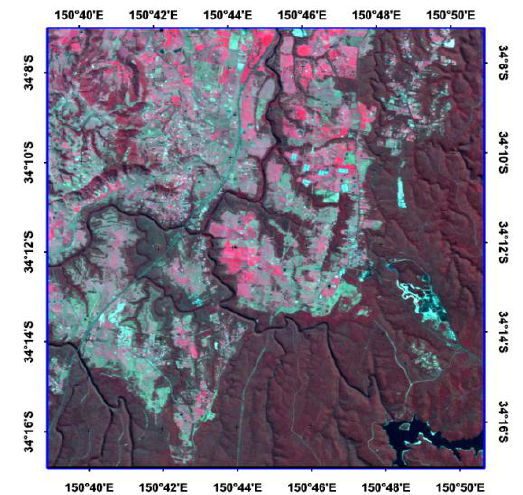
Figure 3. Landsat 5 TM+ images (false colour) acquired on 10/09/2010